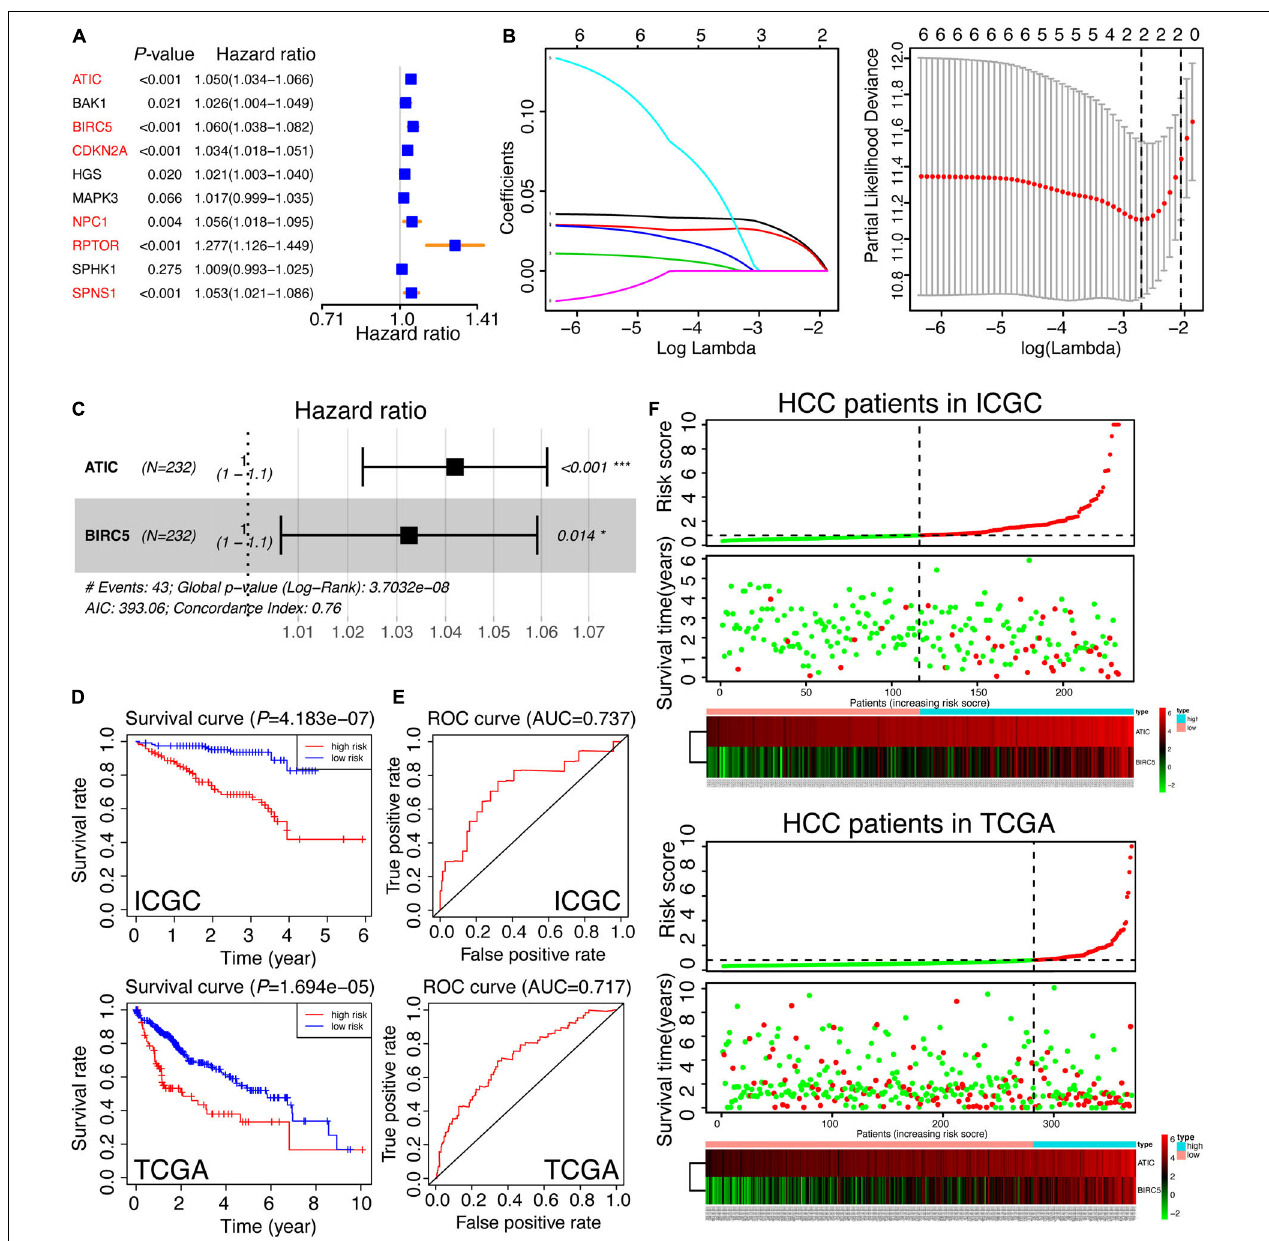
FIGURE 7 | Construction and validation of the autophagy-related gene signature. (A) The univariate analysis of 10 hub genes for HCC patients in ICGC, which was classified as a training set in our study. The genes in red color were recognized as significance ( p < 0.01). (B) The selection of risk factors by LASSO analysis. (C) Multivariate Cox analysis of ATIC and BIRC5 in ICGC and the prognostic signature were constructed. The formula was as follows: RiskScore = 0.04 × ATIC + 0.03 × BIRC5. The Concordance Index was 0.76. (D) The survival curves of HCC patients based on the RiskScore signature in the training set (ICGC) and the testing set (TCGA). (E) The ROC curves calculated by the RiskScore signature in ICGC and TCGA. (F) The thermal maps and distributions of the two gene expression profiles in the high- and low-risk subgroups in the training set and the testing set, respectively. The red circle represents “Dead” while the green circle represents “Alive.” The green curve denotes “low-risk,” and the red curve means “high-risk.” The risk scores of HCC patients in TCGA were calculated by the RiskScore signature and divided into two subgroups according to the medium score of the training